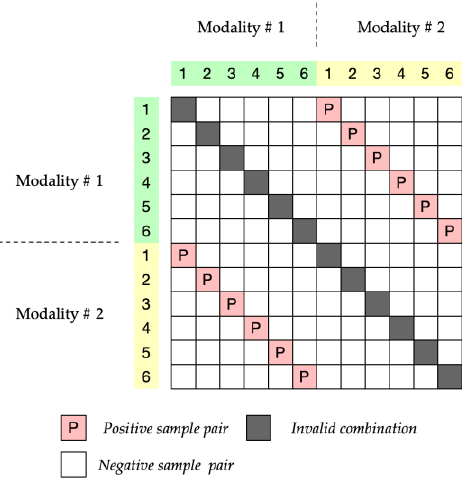
Figure 8. Constructing positive and negative samples in a batch.